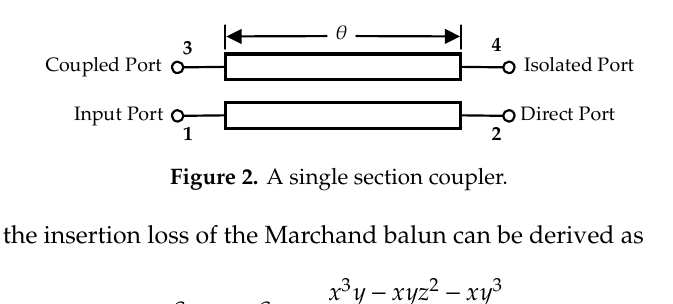
Figure 1. Block diagram of the conventional Marchand balun.